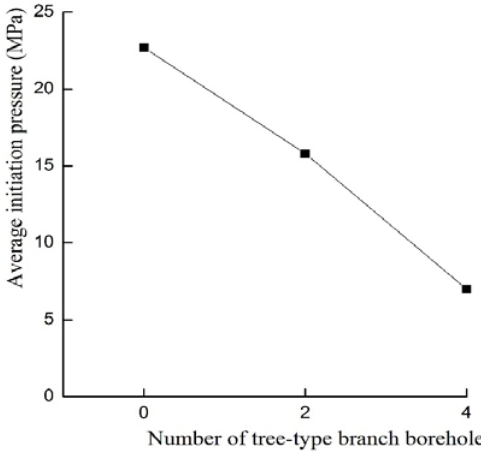
Figure 10. Average initiation pressures as a function of the number of branches in the tree-type borehole arrays in experimental test.